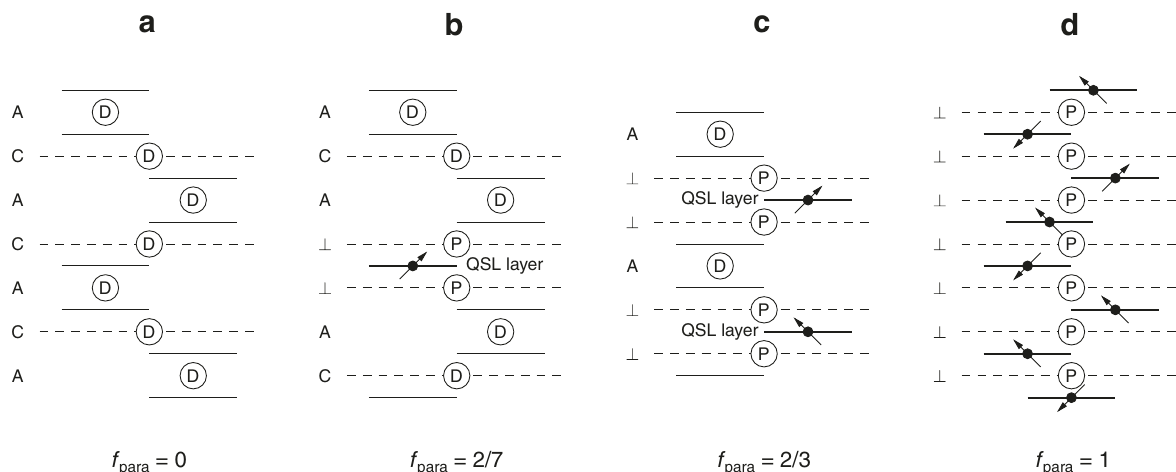
Fig. 7 Layer stacking and the muon relaxation signal. a Regular ACACAC stacking of the triangular-lattice layers of Star-of-David (SD) clusters produces completely spin-paired bilayers that do not support the QSL state. Cleavage at C planes (dashed lines) in such a structure results in bilayer surfaces. Muon sites in this case all see diamagnetic environments (shown as D here). b A defect in the SD stacking sequence at the level of one in seven layers on average gives a sequence such as ACA ⊥⊥ AC for which one in four cleaved surfaces are unpaired monolayers that can support the QSL state. This ratio matches that seen in a recent STM study 24 . The muon stopping sites in this case split between diamagnetic (D) and paramagnetic (P) environments, with f para , the P to D site ratio, being 2/7 for this concentration of stacking defects. c , d Example sequences with greater concentrations of the electronic stacking defects giving more unpaired QSL layers and larger values of f para